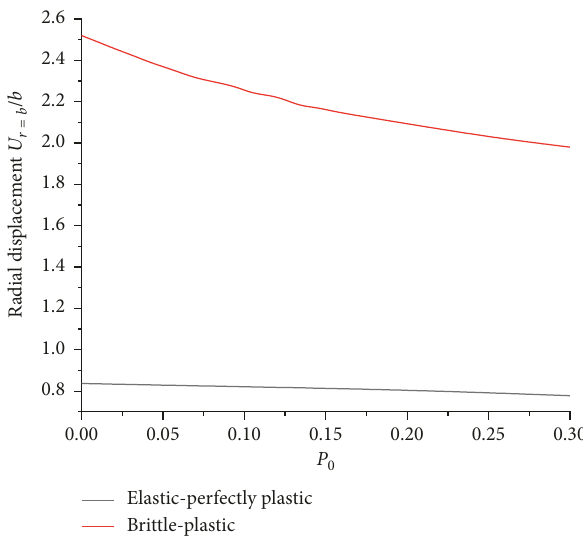
Figure 19: Variation of radial displacement on the opening surface with the change of P 0 based on generalized Hoek–Brown failure